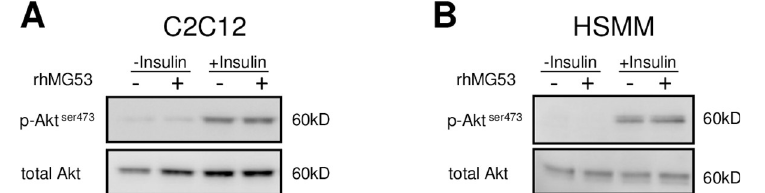
Fig 3. Recombinant human MG53 does not affect insulin response in both C2C12 cells and primary human skeletal muscle myoblasts. Differentiated C2C12 cells (Panel A) or HSMMs (Panel B) were preincubated with rhMG53 (30 μ g/mL) for 1h before being treated with insulin (20nM for 10 minutes and 100nM for 30 minutes, respectively) or vehicle (BSA). Akt phosphorylation was then evaluated by western blot analysis.